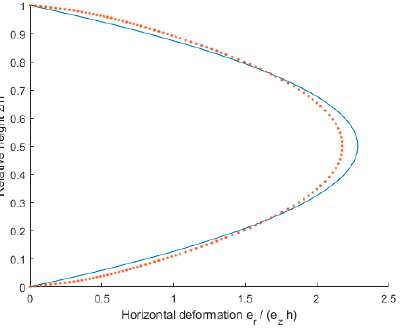
Figure 10. Comparison of the results obtained from [76] and the model made for the research pre- sented in the article. Input parameters e z = 5%, ν = 0.49, r/h = 5, error RMSE = 0.1110. Continuous line—result from [76]; do tt ed line—result from FEM